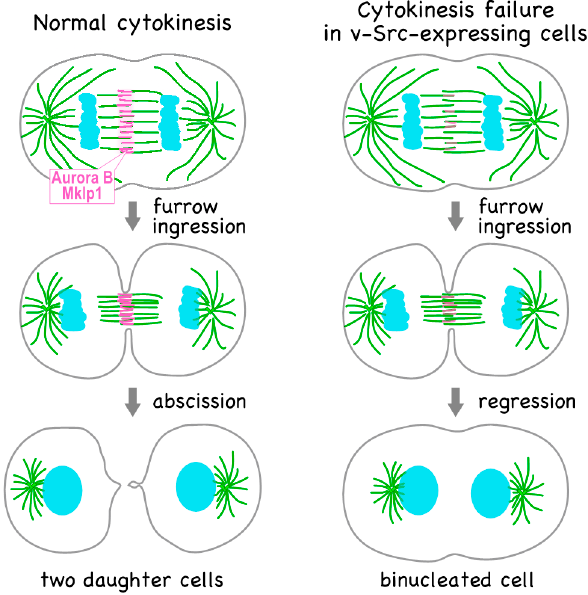
Figure 1. v-Src induces cytokinesis failure. The chromosomal passenger complex (CPC) and centralspindlin complex are localized at the spindle midzone; however, v-Src causes delocalization of the components of these complexes. As a result, cytokinesis fails due to regression of the cleavage furrow, resulting in the formation of binucleated cell.